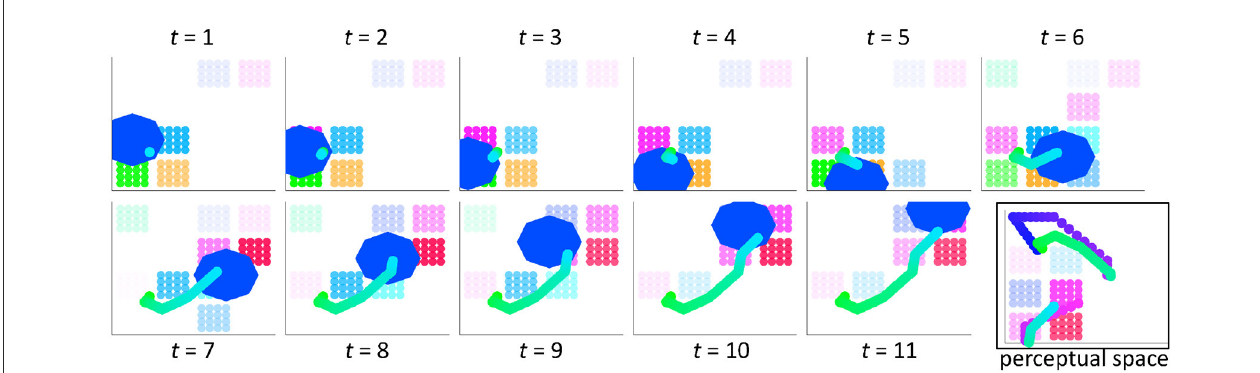
FIGURE4 The perceptual-motor integration of wordforms results in an output trajectory through the perceptual and motor spaces, which are linked via clusters. Activation strength due to the silhouette and exemplar is depicted by the relative transparency/opacity of the clusters. These clusters are shown here in motor space for a silhouette that is 11 time steps in length. The region of the silhouette (blue octagon) is shown at each time step in this space. The resulting trajectory incorporates directional information (line shading from green to cyan blue). The trajectory is also shown in perceptual space, with the exemplar trajectory (dots shading from blue to pink). It is discontinuous in perceptual space because the topology of this space is different from that of motor space.